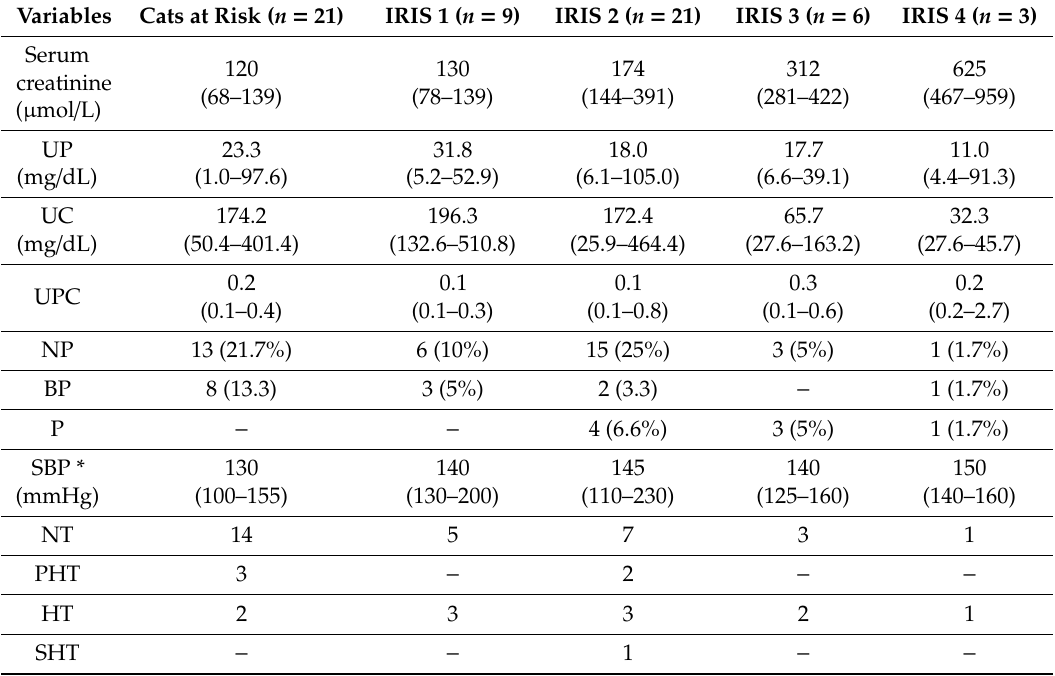
Table 3. Selected clinical and clinicopathologic variables of feline patients grouped according to International Renal Interest Society (IRIS) staging. Samples collected at the time of inclusion and at the di ff erent checkpoints were included. Continuous variables were represented as the median (range). Number and percentage (in brackets) of cases included in each IRIS substage are also